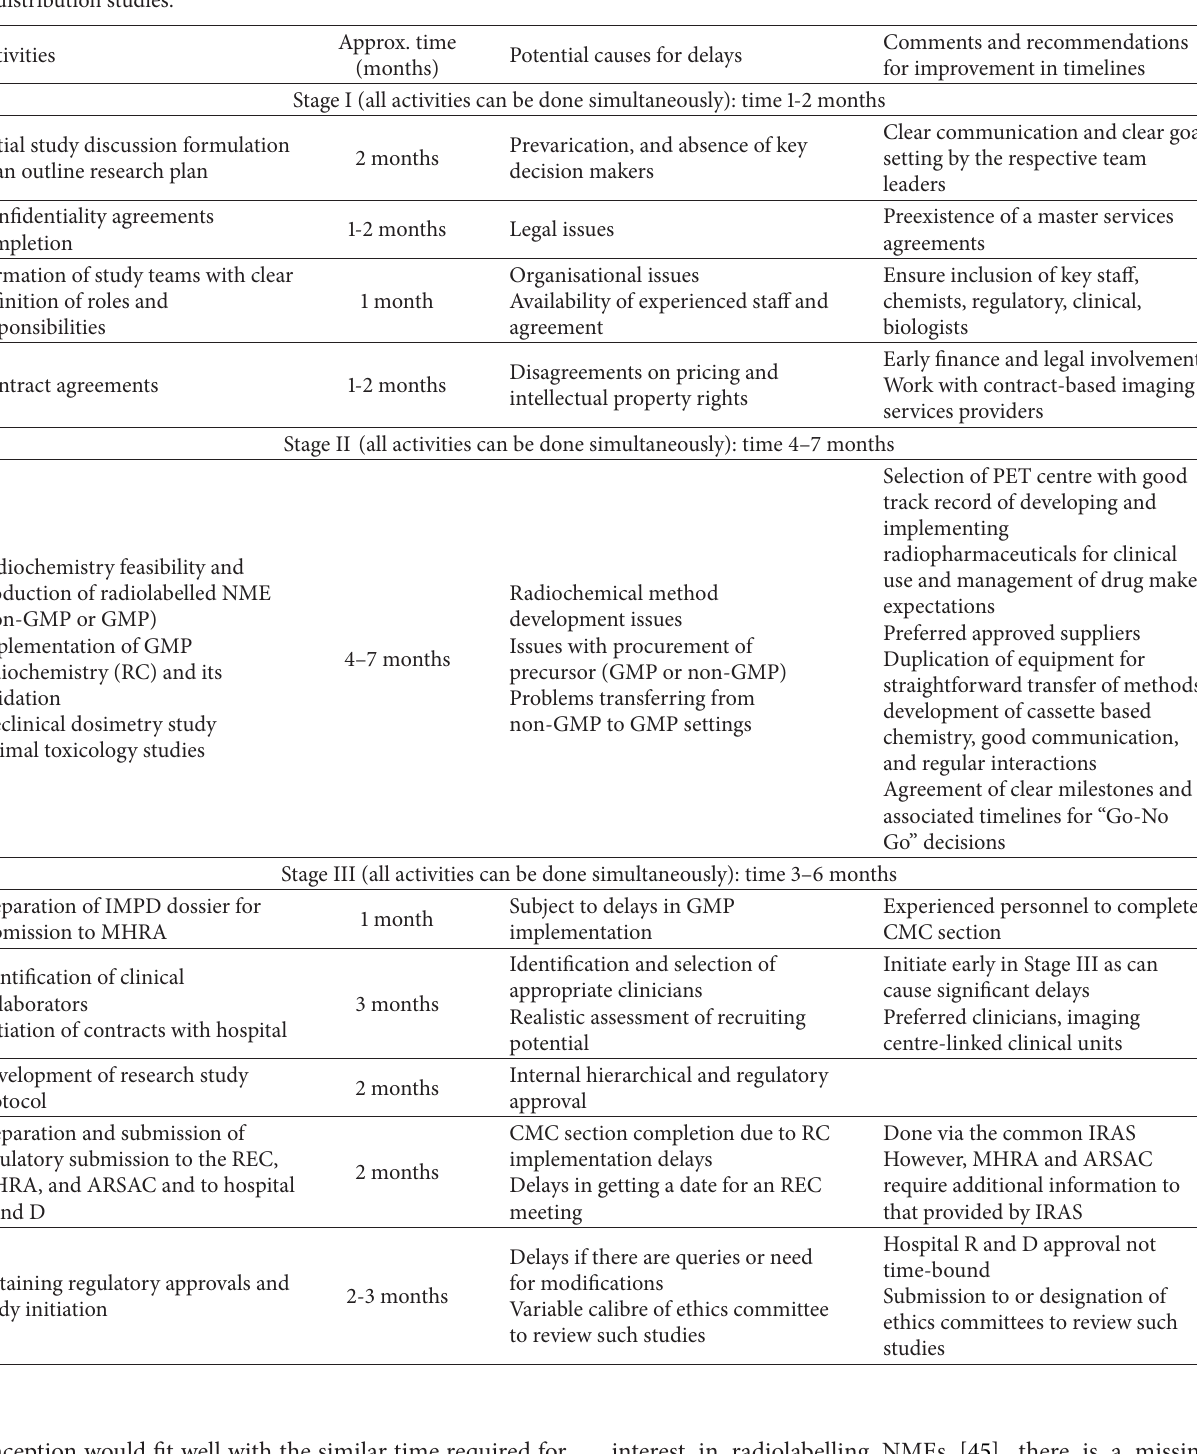
Table 2: Sequential stages of activities, their timelines, potential causes for delays, and recommendations to reduce delays in PET biodistribution